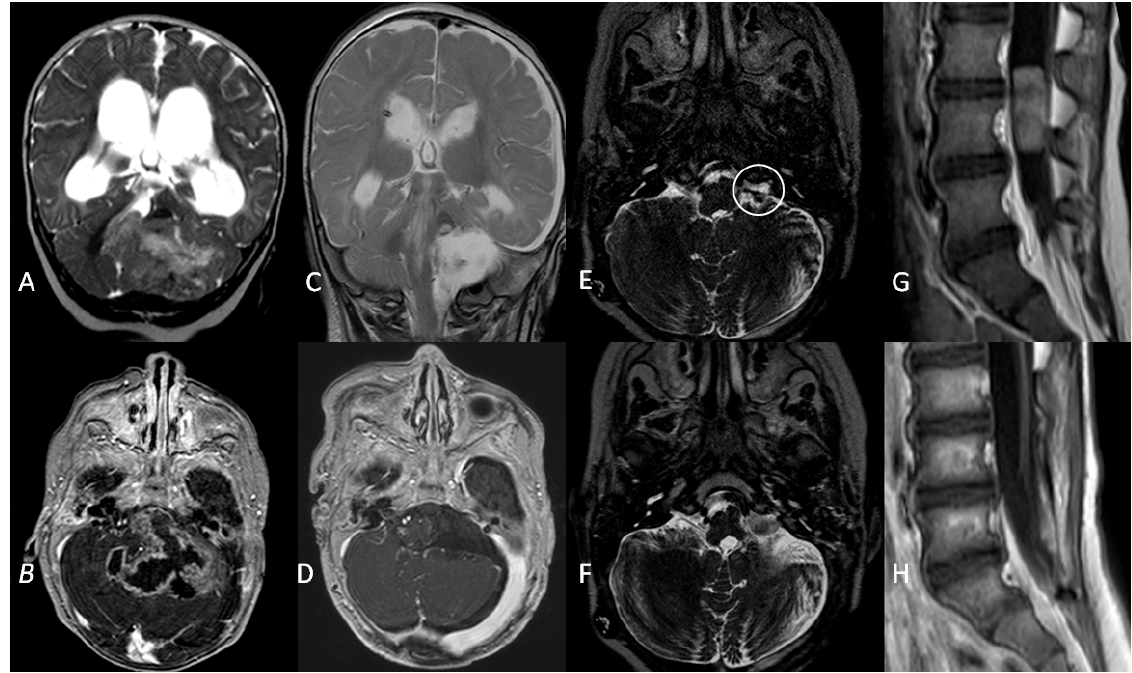
Figure 4. A coronal T2W MRI ( A ) and axial contrast-enhanced T1 W MRI ( B ) showing a posterior fossa tumour involving the left cerebellopontine angle and extending into the fourth ventricle in a 5-month old infant. ( C , D ) Three-month follow-up MRI showing complete surgical resection and VP shunt. ( E ). An axial T2W MRI at 1-year follow-up showing recurrence (white circle) of the tumour in the left lateral recess. ( F ). Gross total resection of the tumour recurrence. ( G ). Metastatic dissemi- nation 22 months after diagnosis (single lumbar metastasis). ( H ). Complete removal of the spinal